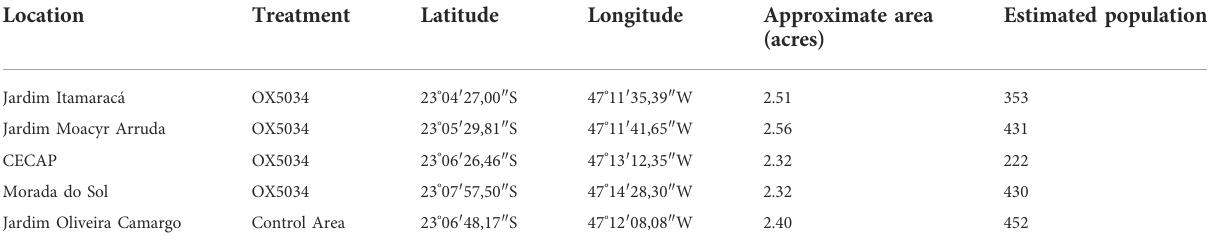
TABLE 3 Geographical coordinates of Treatment Areas and Control Areas, their approximate areas and estimated human population.